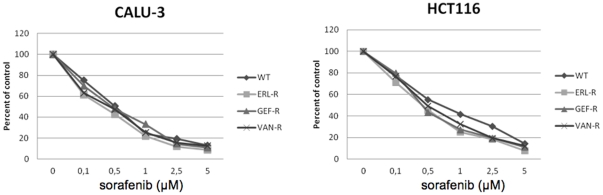
Growth inhibitory effects of treatment with sorafenib in parental and TKI-resistant CALU-3 and HCT116 cancer cells.MTT cell proliferation assays were performed in parental lung adenocarcinoma CALU-3 and colorectal cancer HCT116 cells. (WT) and in their TKI-resistant derivatives (ERL-R, GEF-R, VAN-R ), treated for three days with the indicated concentrations of sorafenib. Results represent the average (±SD) of three separate experiments, each performed in quadruplicate.